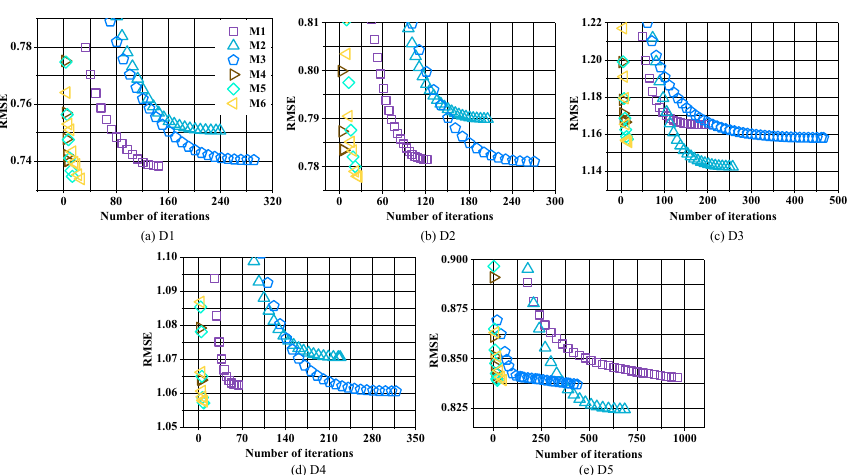
Fig. 2 RMSE Comparison of M1 to M6 on D1 to